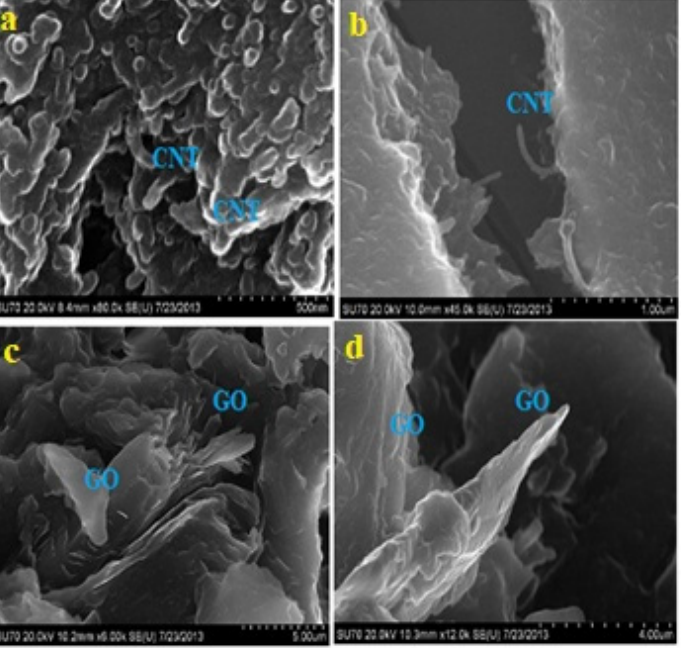
Figure 3. Cross section SEM images of ( a , b ) for GO@isocyanate 50 wt.% ( c , d ) for FCNT@isocyanate 50 wt.%.